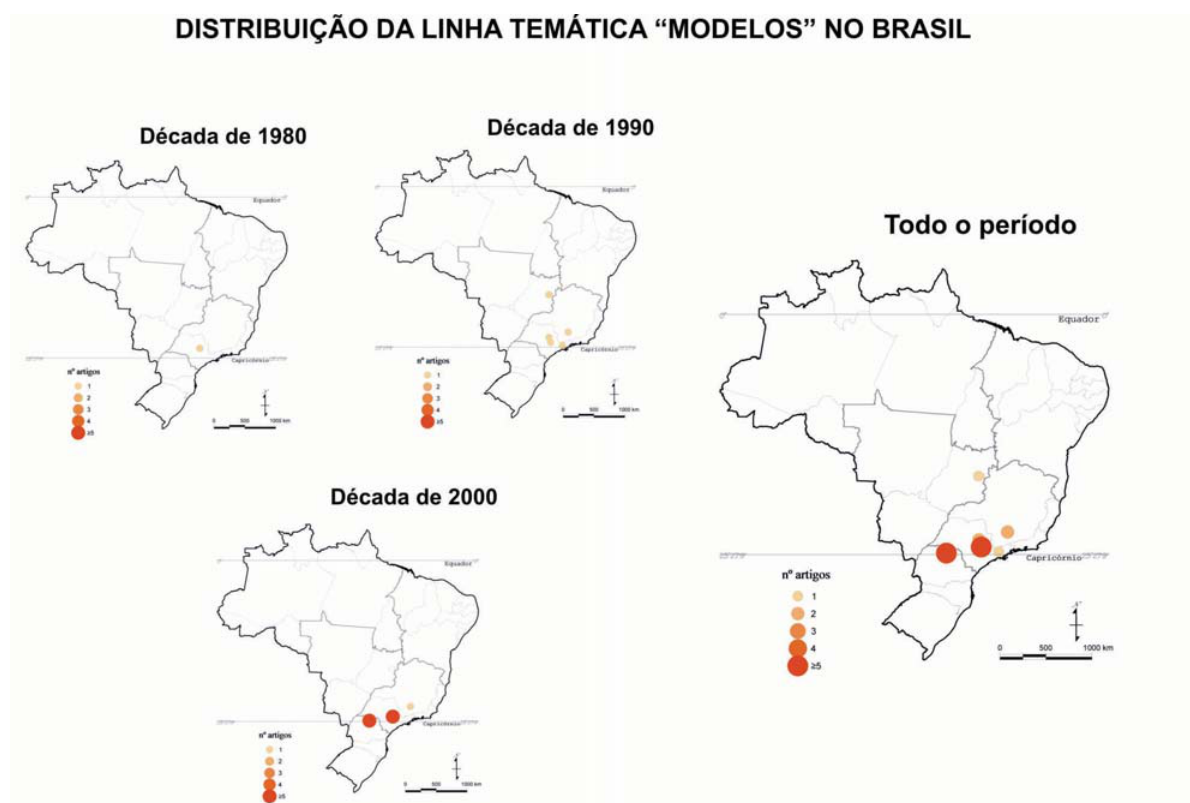
Figura 7. Distribuição espacial da produção de artigos na linha temática “MODELOS” por